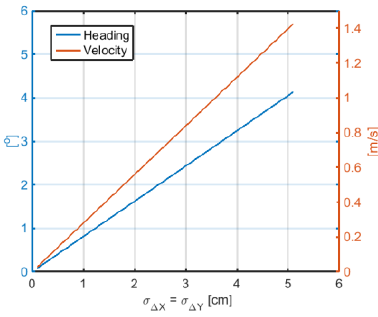
Figure 2. Estimating errors of the